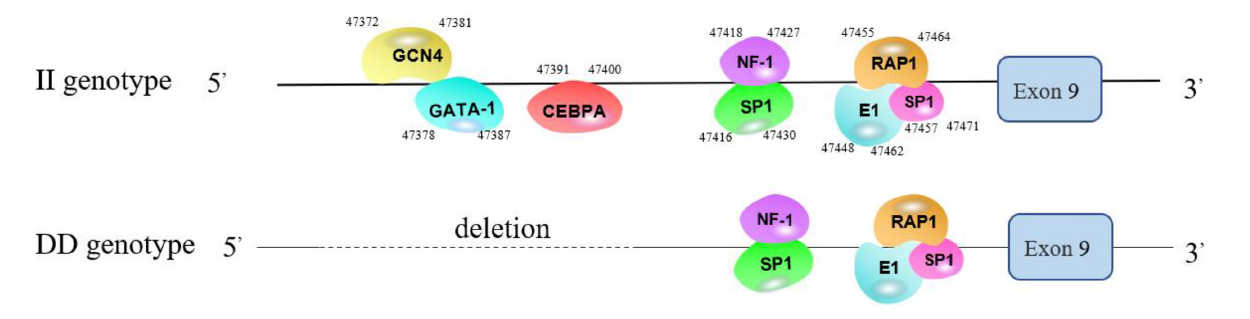
FIGURE 7 | Predicted binding sites of transcription factors in the different